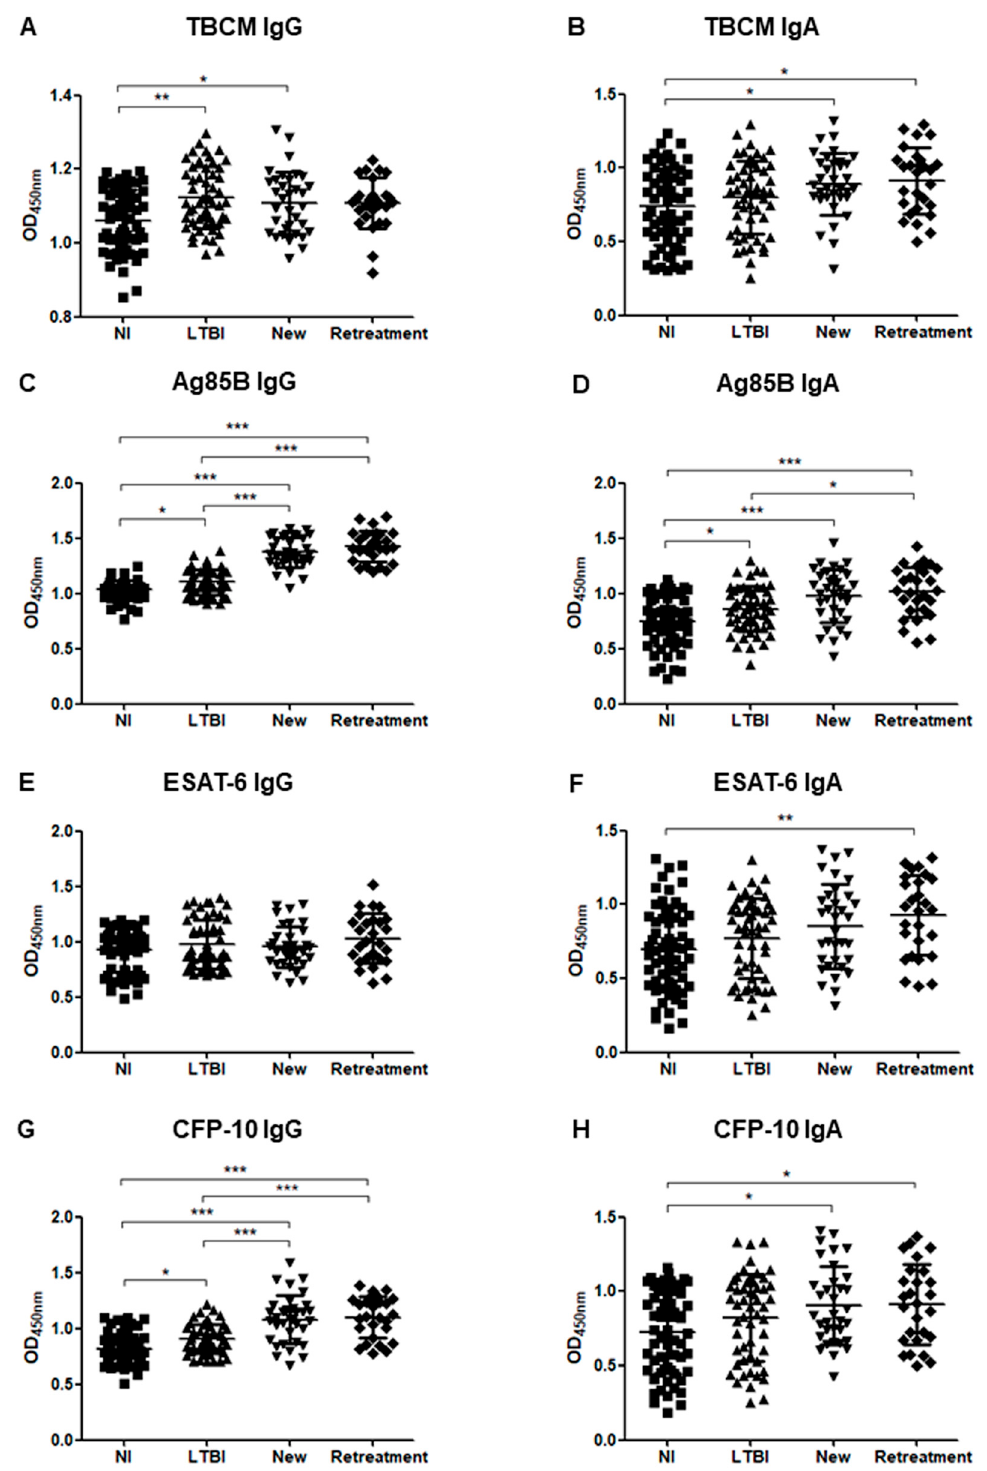
Figure 4. The optical density (OD) values of the anti-TBCM IgG ( A ), anti-TBCM IgA ( B ), anti-Ag85B IgG ( C ), anti-Ag85B IgA ( D ), anti-ESAT-6 IgG ( E ), anti-ESAT-6 IgA ( F ), anti-CFP-10 IgG ( G ), and anti-CFP-10 IgA ( H ) serodiagnosis assays for the comparison of 34 new patients, 27 retreatment patients, 53 latent tuberculosis infection patients (LTBI), and 62 non-infected individuals (NI). Each dot represents the values obtained from individual subjects, and horizontal bars indicate the average values. Groups were compared by one-way ANOVA with Bonferroni’s multiple comparisons. * p < 0.05; ** p < 0.01; *** p < 0.001.